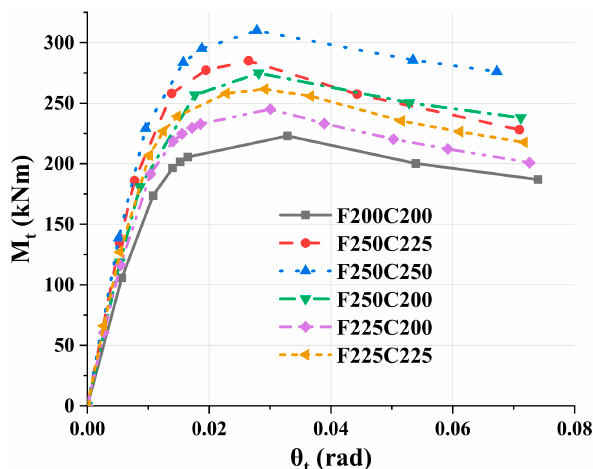
Figure 25. Moment-rotation curves of connections with different beams